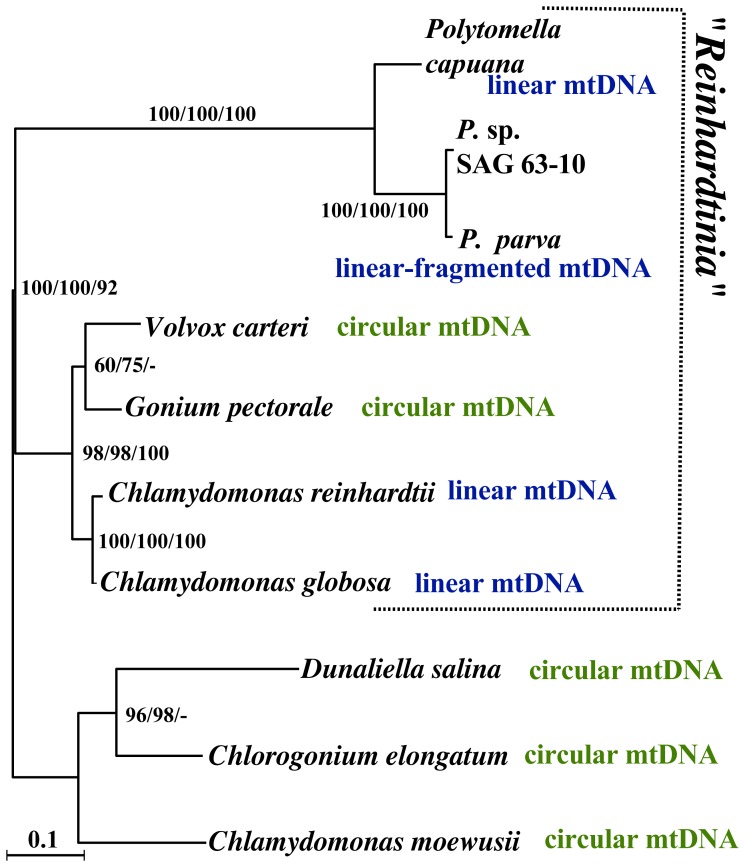
MtDNA protein phylogeny of seven species belonging to Reinhardtinia clade and three outgroup species from the Volvocales.The tree was constructed under the RAxML (with WAG+I+4G model) method using the concatenated sequences of the deduced nad5, cox1, and cob amino acid sequences. Left, middle, and right bootstrap values (≥50%) obtained using the RAxML, PhyML (with LG+I+4G model), and MP analysis, respectively. The amino acid sequences of the three proteins were aligned by Clustal X [29], and ambiguously aligned and highly variable regions were removed to construct a multiprotein data matrix of 909 amino acids from the 10 operational taxonomic units (Table S1).